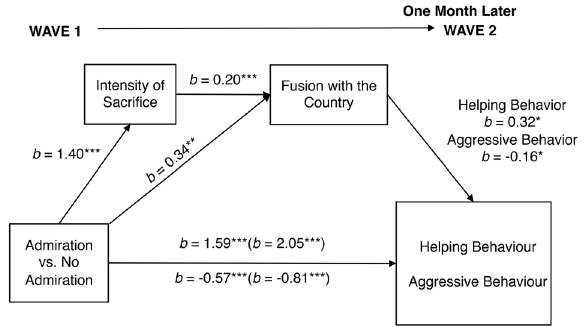
Fig. 6 Linear mediation model in Study 6 ( N = 771 vs. 376 for waves 1 and 2, respectively). For helping behaviour, condition in fl uenced helping behaviour via (1) identity fusion alone, b = 0.11, 95% CI [0.01, 0.25], (2) intensity of the sacri fi ce alone, b = 0.57, 95% CI [0.07, 1.05], and (2) intensity of sacri fi ce and fusion with country serially, b = 0.09, 95% CI [0.003, 0.07]. For aggressive behaviour, condition in fl uenced aggressive behaviour via (1) identity fusion alone, b = − 0.07, 95% CI [ − 0.16, − 0.01], (2) intensity of the sacri fi ce alone, b = − 0.36, 95% CI [ − 0.64, − 0.09], and (3) intensity of sacri fi ce and fusion with country serially, b = − 0.06, 95% CI [ − 0.12, − 0.01]. Note. * p < 0.05; ** p < 0.01; *** p <